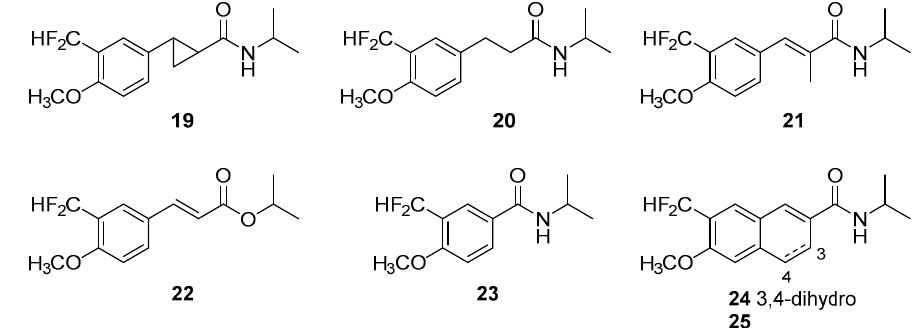
Figure 3. Analogs of 11b with modified side chains.